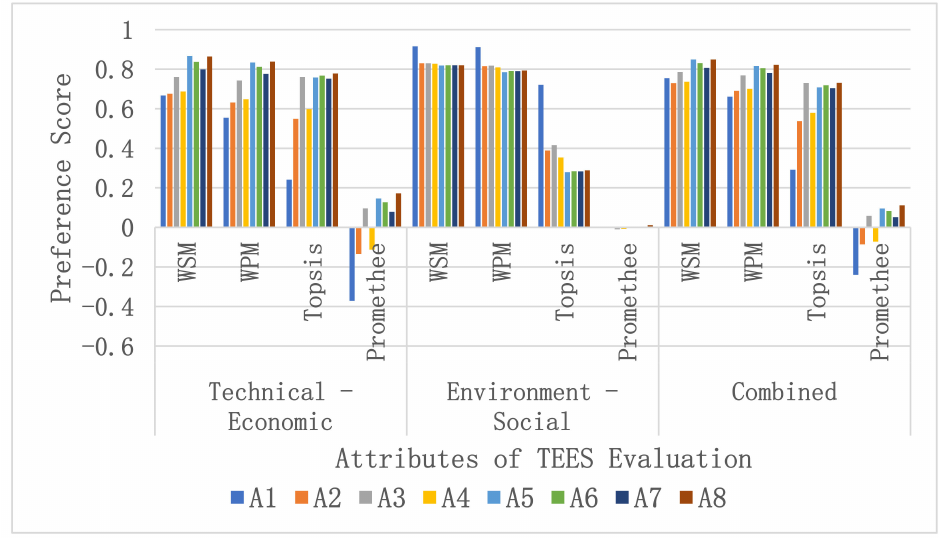
Figure 10. Attributes of TEES evaluation for C1/S3 with DGs only at 0.9 PF under OLG1. Detailed evaluations of C1/S4 in terms of MCDM methodologies are shown in